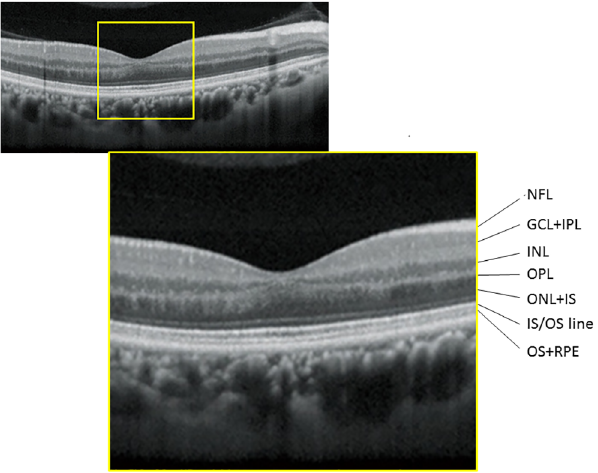
Fig 1. Macular retinal layer thickness measurements in a sample case. NFL: nerve fiber layer, GCL+IPL: ganglioncell and inner plexiform layer, INL: inner nuclearlayer, OPL: outer plexiformlayer, ONL+IS: outer nuclear layer and inner segment layer: OS+RPE outer segment layer and retinal pigmentepithelium.